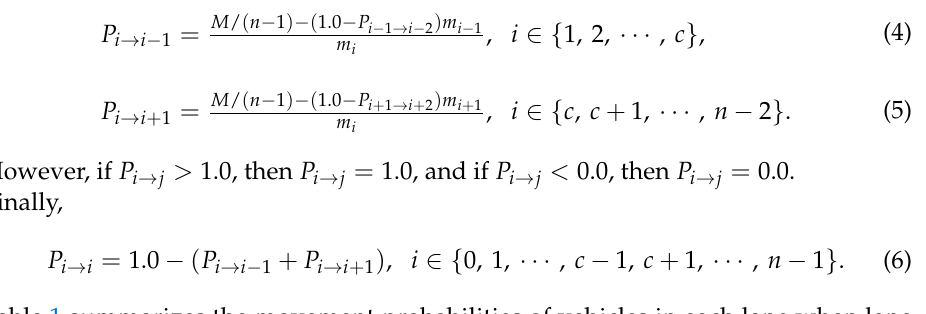
and goes straight ahead with a probability ( M /2 − m 0 ) / m 1